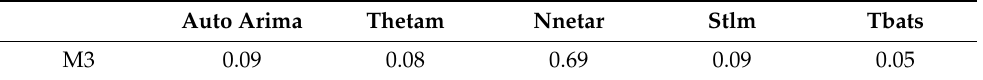
Table 6. The M3 model’s component weights for loneliness score forecasting.